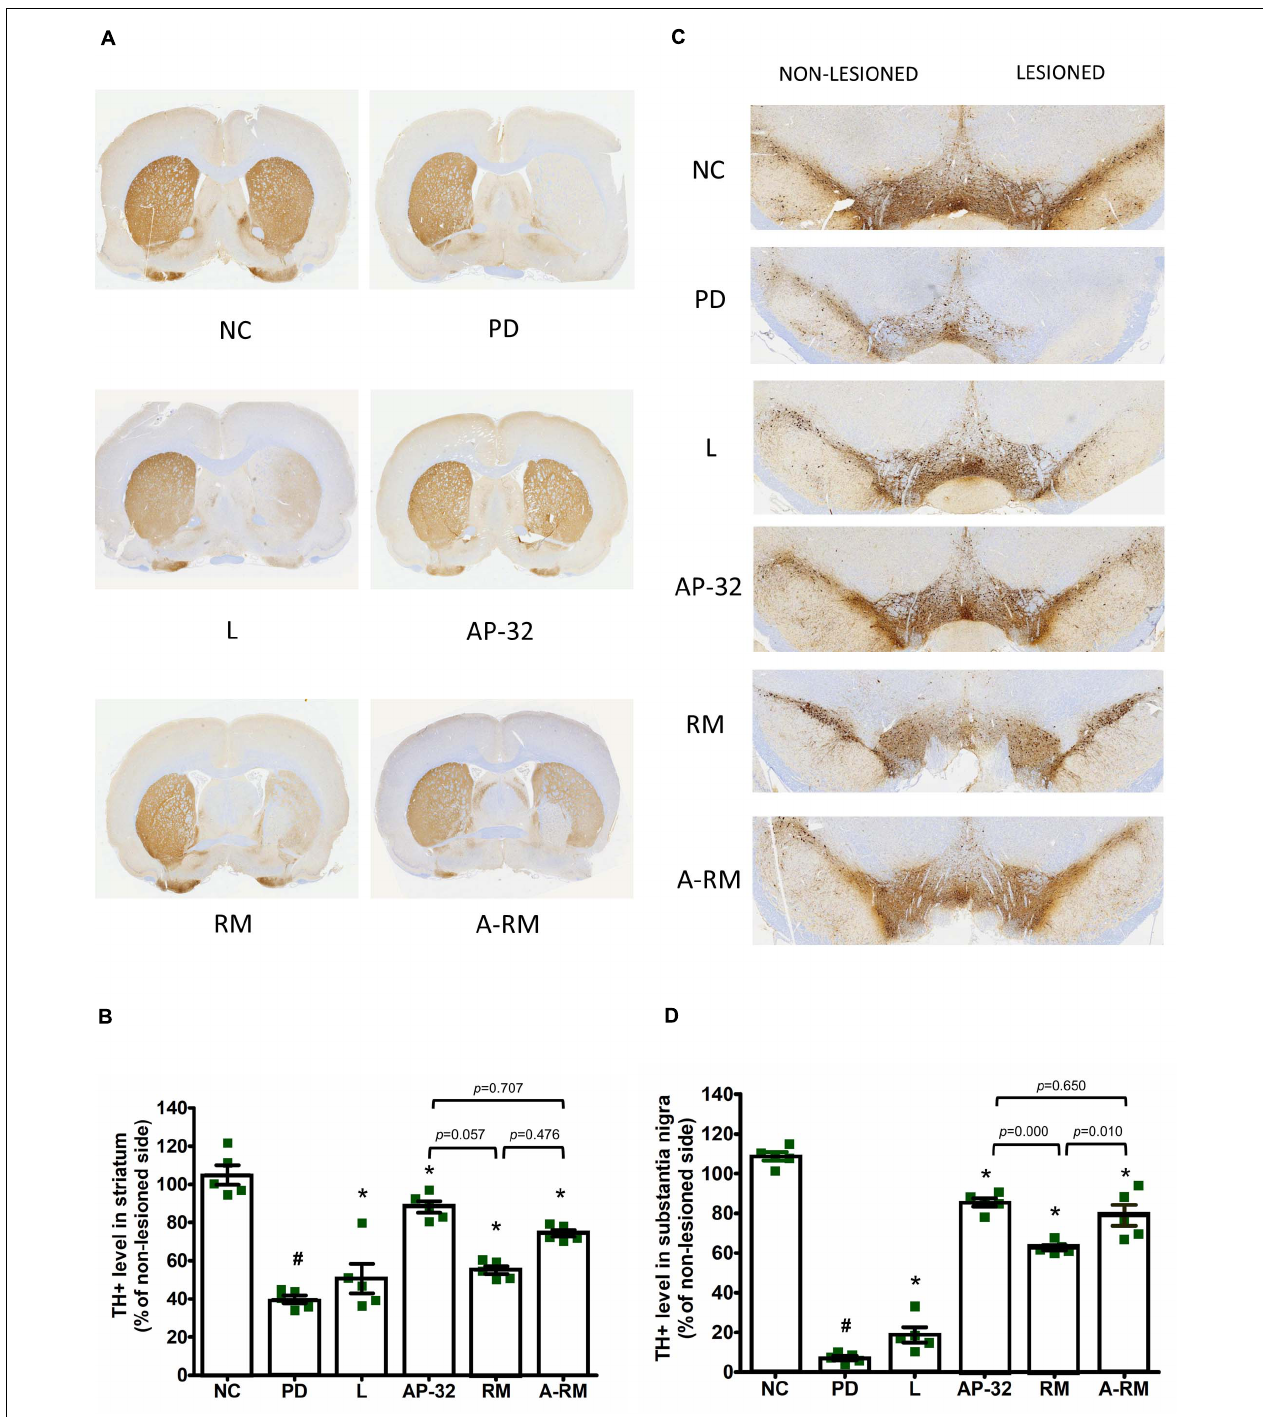
FIGURE 2 | Supplementation of AP-32, RM, and A-RM rescued the 6-OHDA-mediated reduction of dopaminergic neurons in the striatum and substantia nigra pars compacta (SNc) after 8-weeks of supplementations. (A) A representative of the immunohistochemical staining for TH (dopaminergic neuron marker) in the striatum. (B) Quantitative analysis of the number of TH-positive cells in the striatum. (C) A representative of the immunohistochemical staining for TH in SNc. (D) Quantitative analysis of the number of TH-positive cells in the SNc. The intensity of the lesioned side was standardized with the non-lesioned side and reported as mean ± SEM ( n = 5 rats/group). # p < 0.05 PD group compared to NC group. * p < 0.05 L, AP-32, RM, and A-RM groups compared to PD group. Data were evaluated by one-way ANOVA with Tukey’s post hoc